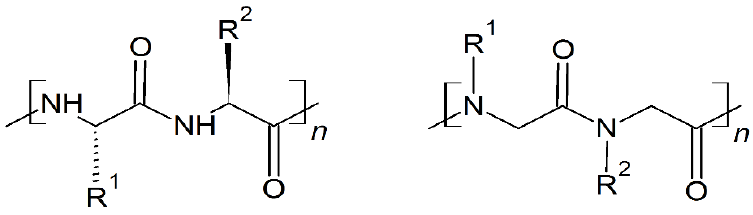
Scheme 4. Chemical structures of peptides ( left ) and peptoids ( right